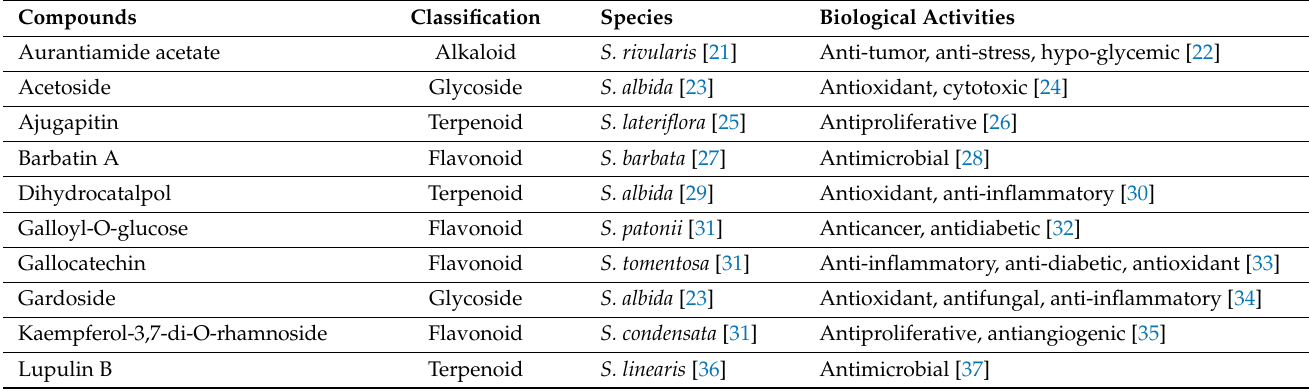
Table 1. Major bioactive compounds identified in the genus Scutellaria .